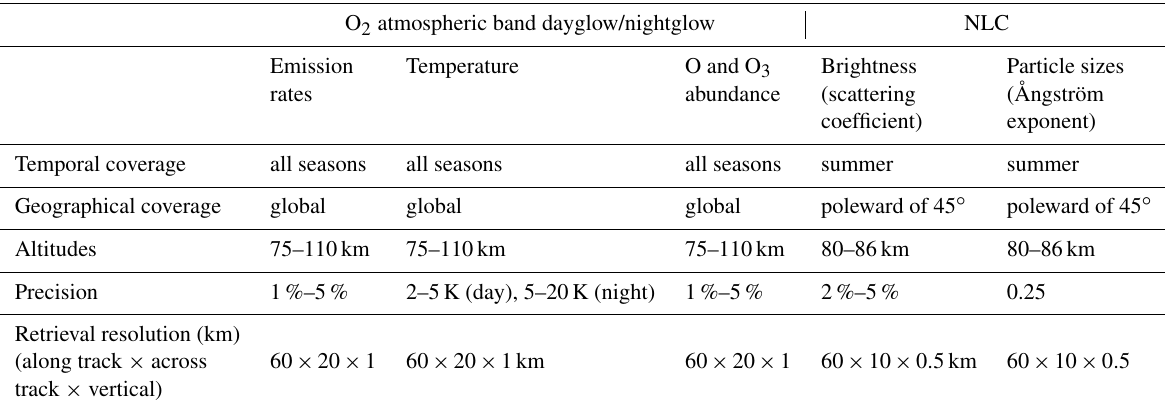
Table 1. Products of the tomographic/spectroscopic retrievals from the MATS limb measurements. These serve as input to subsequent wave analysis.